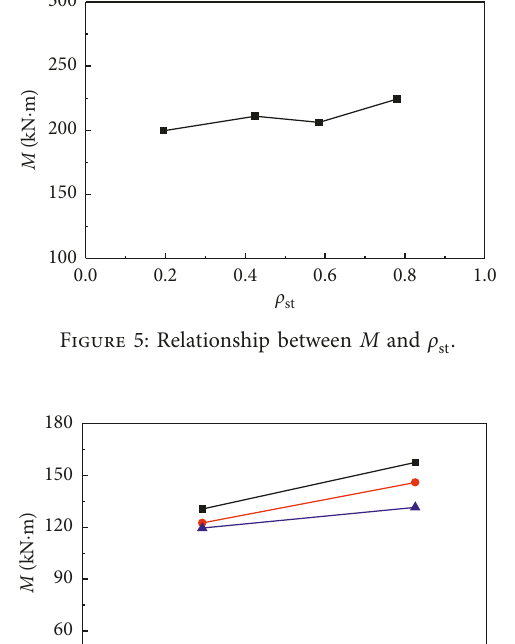
Table 2: Properties of steel and concrete.